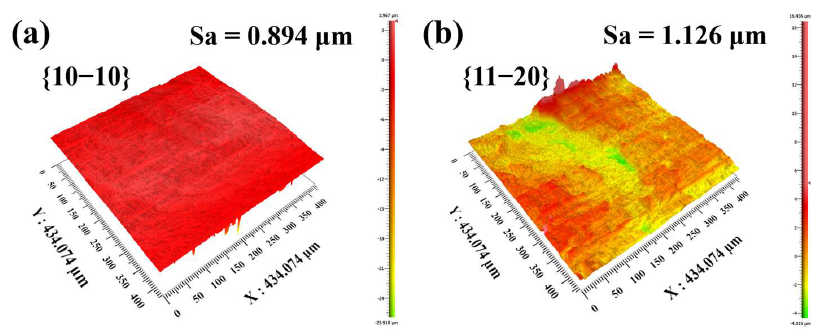
Figure 5. Cross sections of the PLSD kerfs along different crystal orientations or planes. ( a ) The cross section of crystal plane {10−10} and ( b ) the cross section of crystal plane {11−20}.